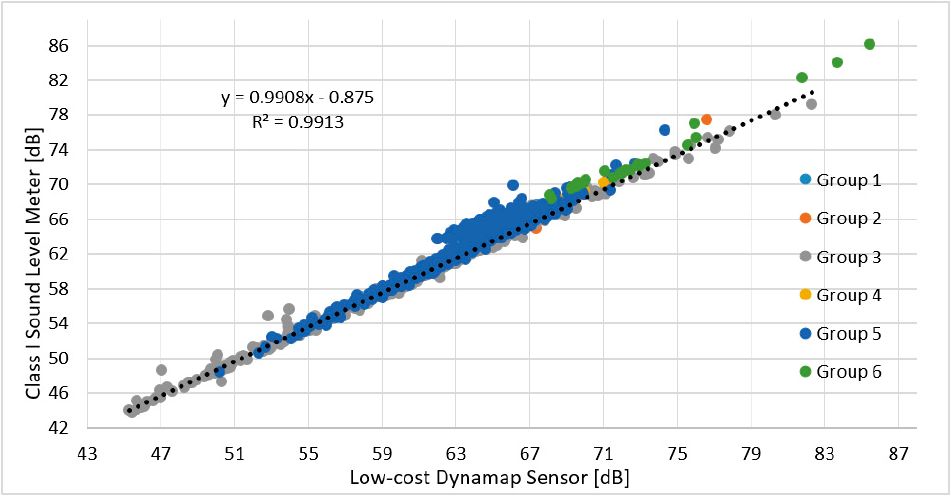
Figure 11. Correlation between the Class 1 Sound Level Meter and DYNAMAP Sensors. Di ff erent colors refer to sensors in each group of streets.